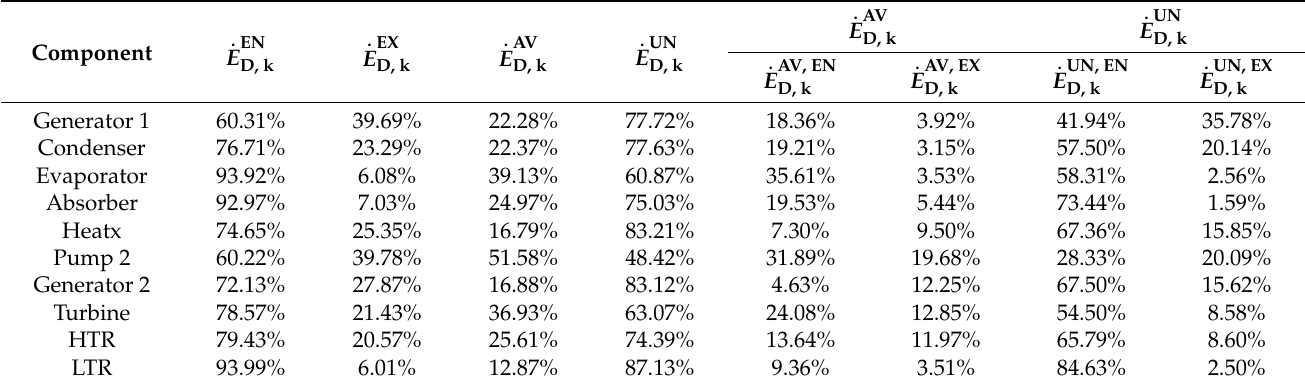
Table 5. Exergy destruction distribution of each considered